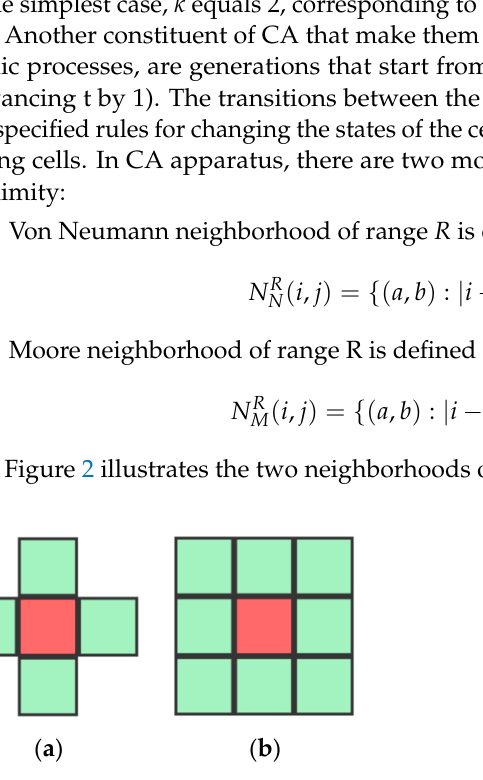
Figure 2. Illustrations of von Neumann ( a ) and Moore ( b ) neighborhoods of range 1.